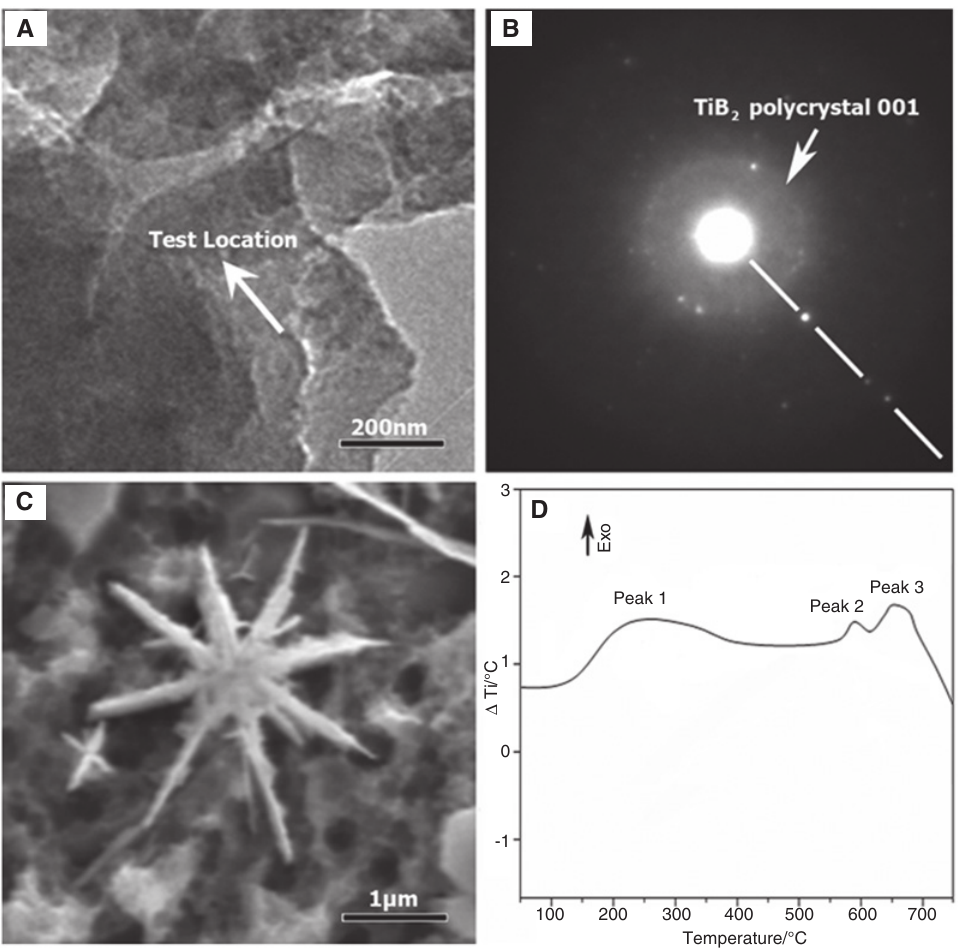
Figure 4 TEM selected location (A) and its electron diffraction pattern (B); SEM micrograph of octagon-shape precipitate (C) and the dif- ferential thermal analysis (DNA) curve of such a laser clad coating